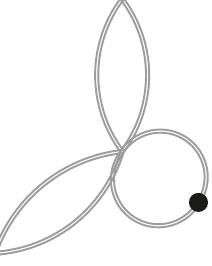
Figure 8 (a). Clover diagram in Higgs regular- ization. Double lines stand for massive propaga- tors.